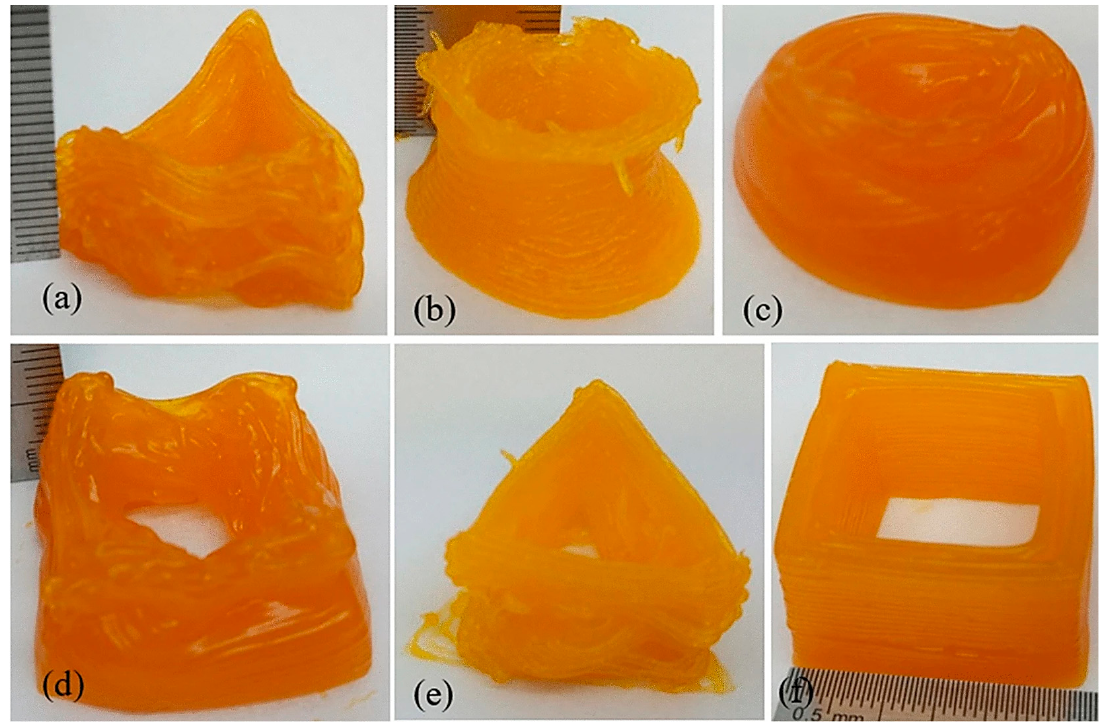
Figure 9. Three-dimensionally printed samples of OC-WS and OC-WS-gum blends. ( a ) Hollow triangle, ( b ) cylinder, ( c ) hollow cylinder, ( d ) hollow square, ( e ) hollow triangle, and ( f ) hollow square. Picture taken from an article by Waghmare et al. [37].